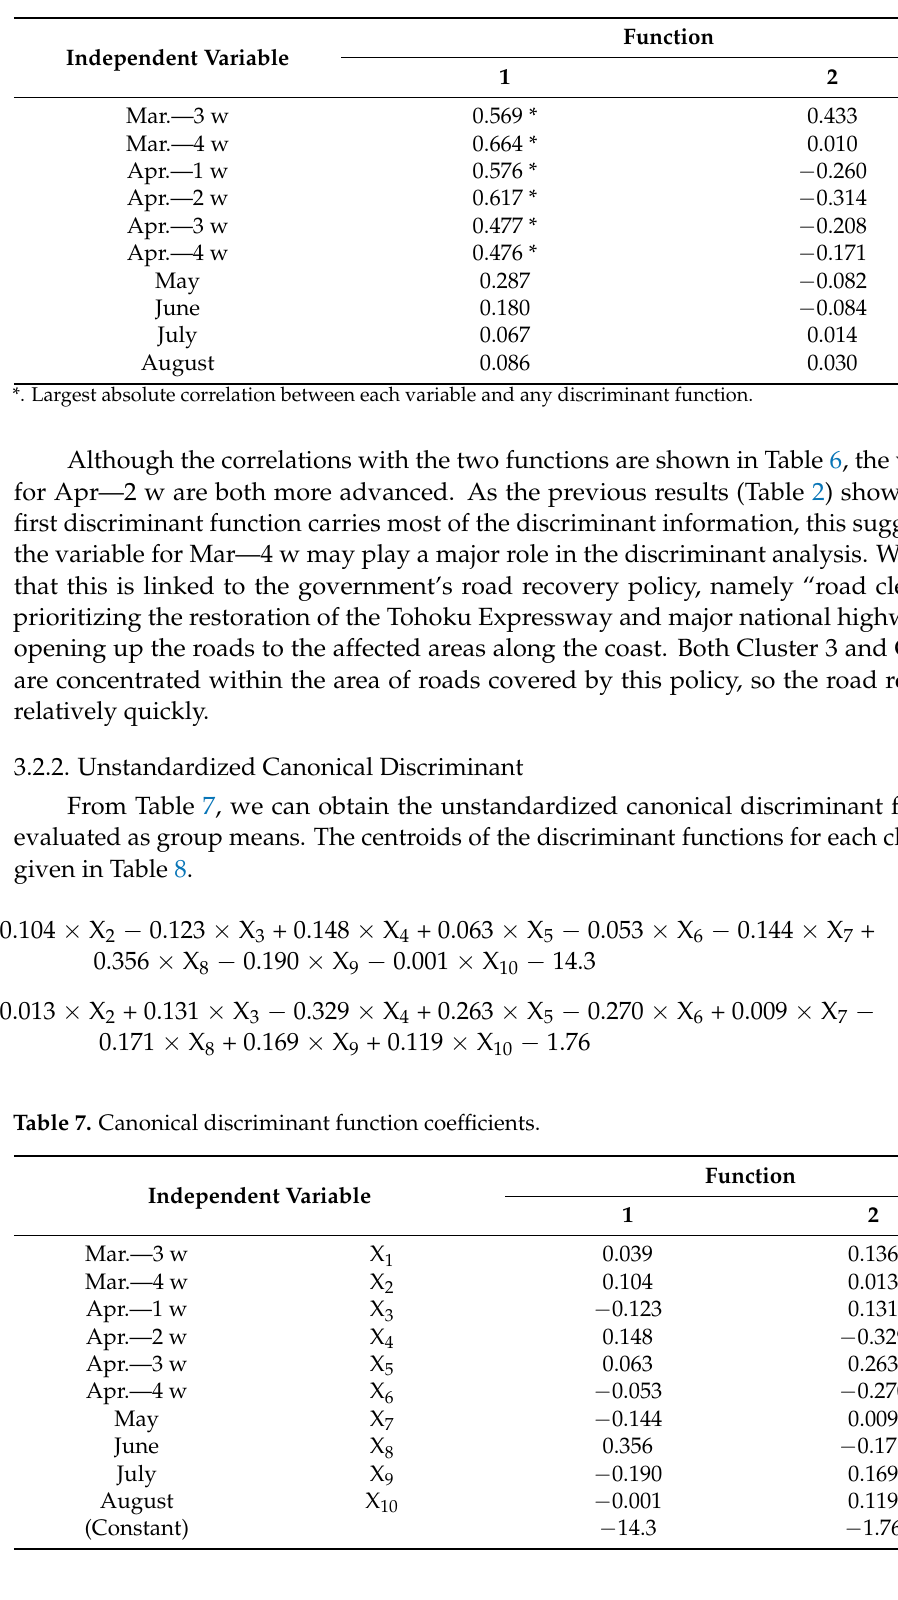
Table 6. Structure matrix.